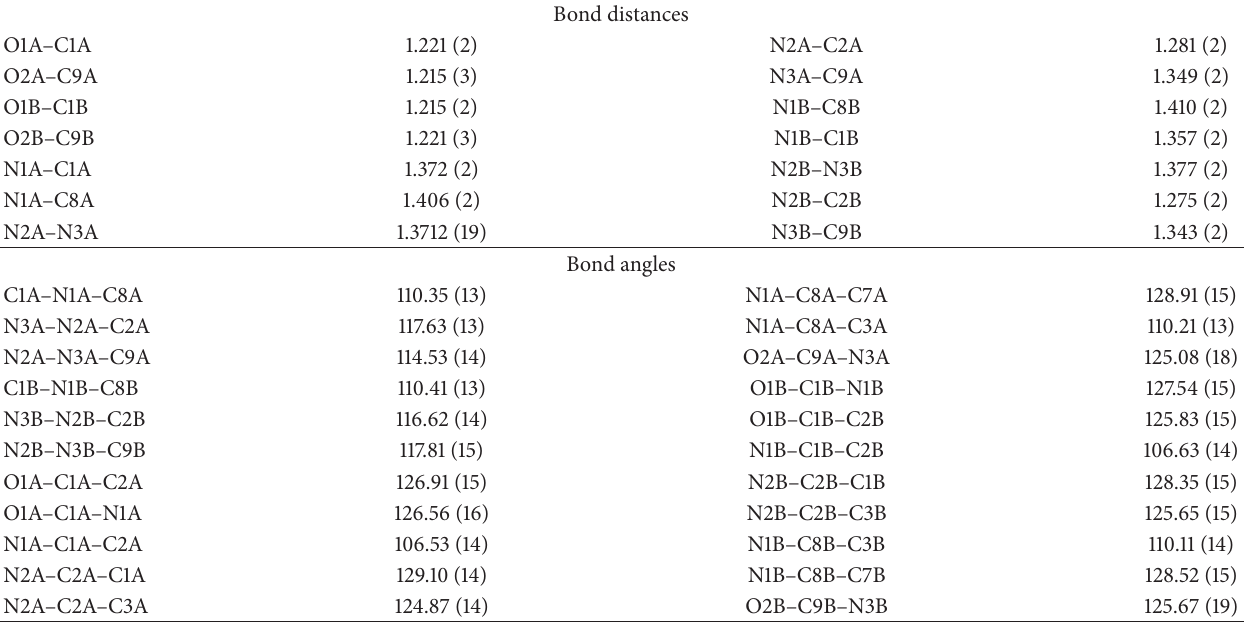
Table 2: Selected bond distances (˚A) and bond angles ( ∘ ) of compound 2 .